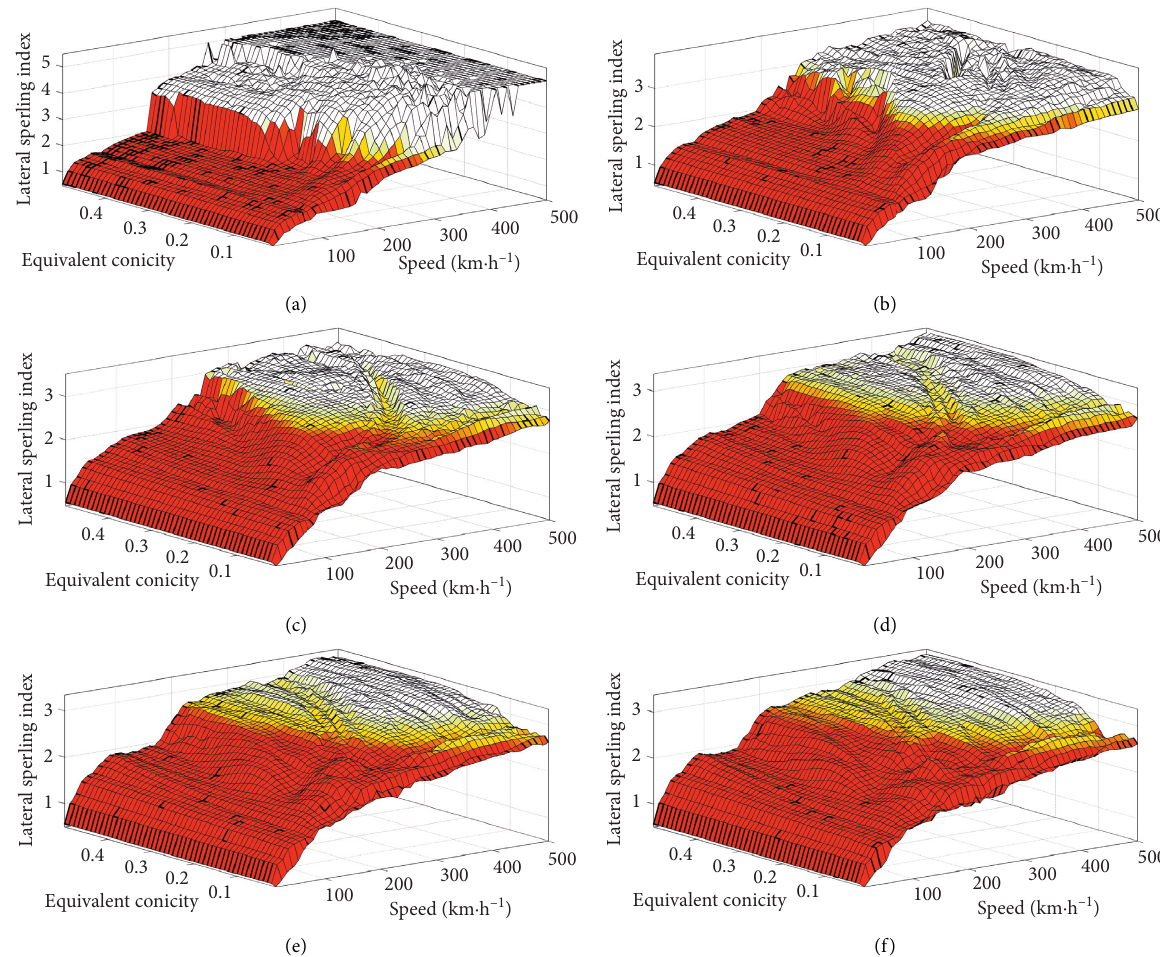
Figure 15: Vehicle ride quality space with joint stiffness of 25 MN · m − 1 and additional stiffness of 0. (a) c � 0. (b) c � 110kN · s · m − 1 .